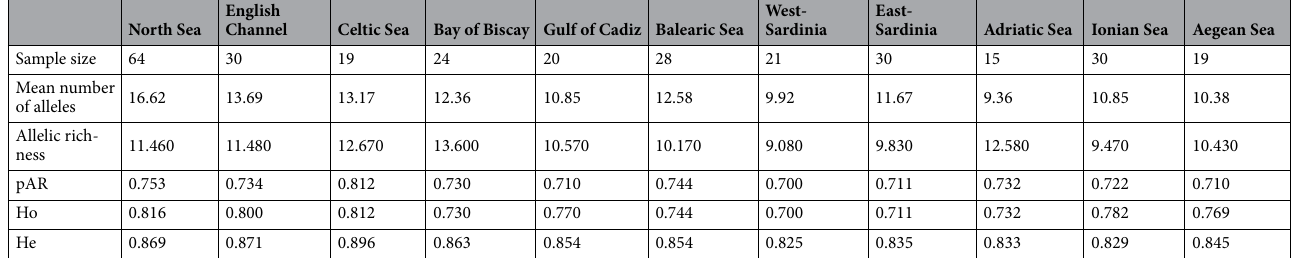
Table 1. Overview of the average values of the microsatellite analysis per respective sampling area; allelic richness and private allelic richness (pAR) based on 15 individuals; Ho = observed heterozygosity; He = expected Heterozygosity; information for separate loci in Supplementary Table S4 online.